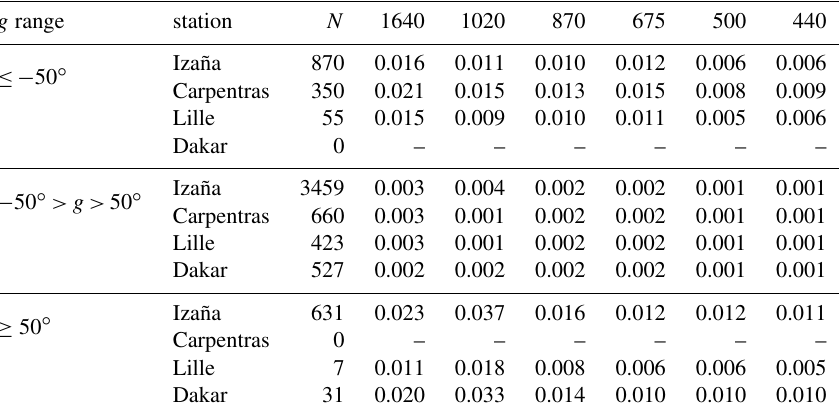
Table 4. Average AOD difference between corrected and non-corrected AOD ( (cid:49) AOD) measured at four different stations in 2016. The number of nighttime measurements ( N ) is